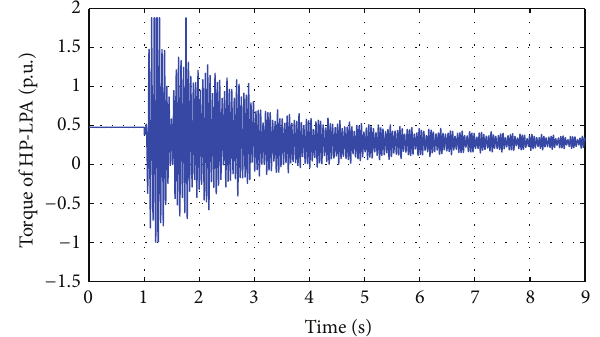
and the triggering angle is turned to be stabilized after the subsidence of torque. This shows that SVC with this control of the torque in order to achieve stable torque.